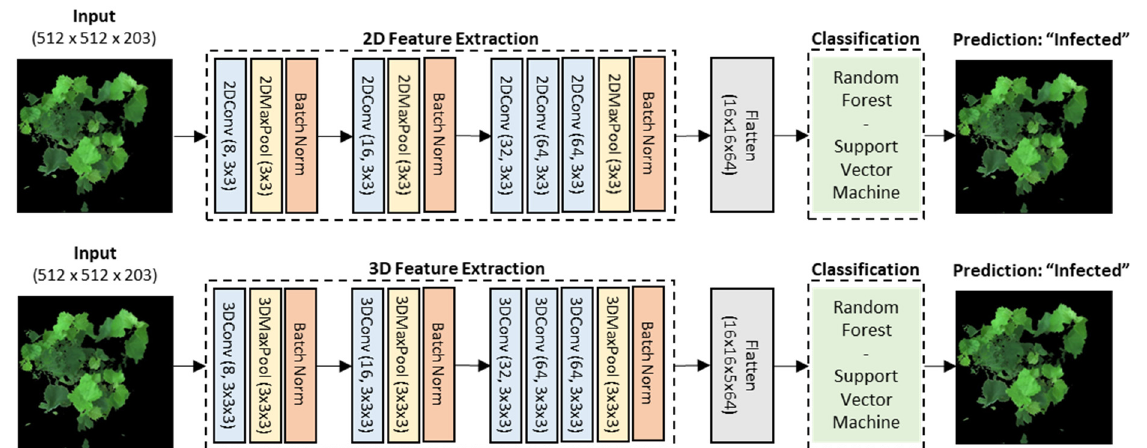
Figure 5. The architecture diagram for the image-wise classification. The original dimensions of the hyperspectral images were 512 × 512 pixels × 203 spectral bands. The automated feature extraction network used was an architected based on AlexNet [78], but the hyperparameters filters, kernel sizes, and pool sizes were experimented on in parallel and were kept the same for both the 2D- and 3D-CNN for a comparison. The 2D-CNN reduced the data cubes to 16 spatial features × 16 spatial features × 64 convolutional filters, while the 3D-CNN reduced the data cubes to 16 spatial features × 16 spatial features × 5 spectral features × 64 convolutional filters. Reduced features were flattened and supplied to the RF and SVM machine learning classification pipelines.